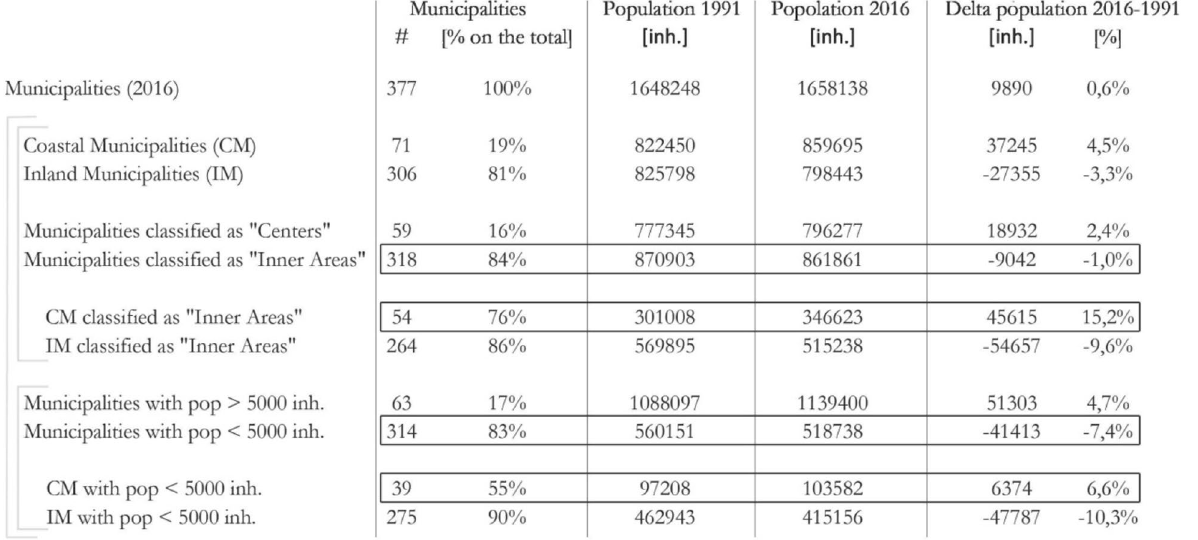
Table 1 Trends of increase/decrease of population in Sardinia, 1991–2016. Source: Elaboration from Istat